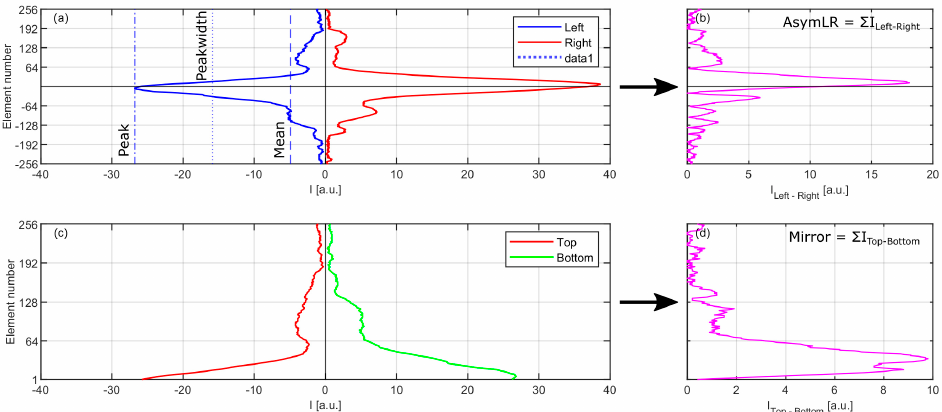
Figure 1. Schematic of the complementary metal-oxide-semiconductor (CMOS) array data and parameters derived from a 3 µm polystyrene latex sphere particle. ( a ) Raw intensity data from the left and right CMOS arrays. Array peak, mean and peakwidth values are indicated by dashed, dot-dashed and dotted lines, respectively. Horizontal black line indicates array midpoint; ( b ) Modulus of the element by element subtraction of the left and right arrays. The resultant sum is the AsymLR parameter; ( c ) Raw intensity of the top and bottom sections of the left CMOS array, starting from the middle of the array outwards; ( d ) Modulus of the element by element subtraction of the top and bottom sections of the left CMOS array. The resultant sum is the Mirror parameter.